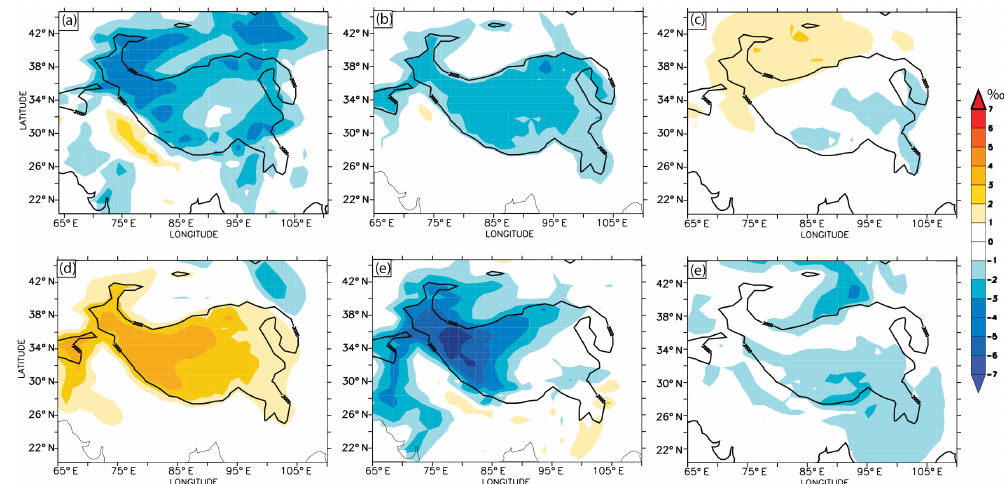
Figure 10. (a) Total isotopic difference between INT and LOW experiments ( (cid:49)R p ) and spatial isotopic variations related to the following: (b) direct effect of topography changes, (c) effect of lapse rate change, associated with non-adiabatic effects, (d) effect of local relative humidity change, (e) effect of changes in post-condensational processes, (f) all other effects (see Table 1).